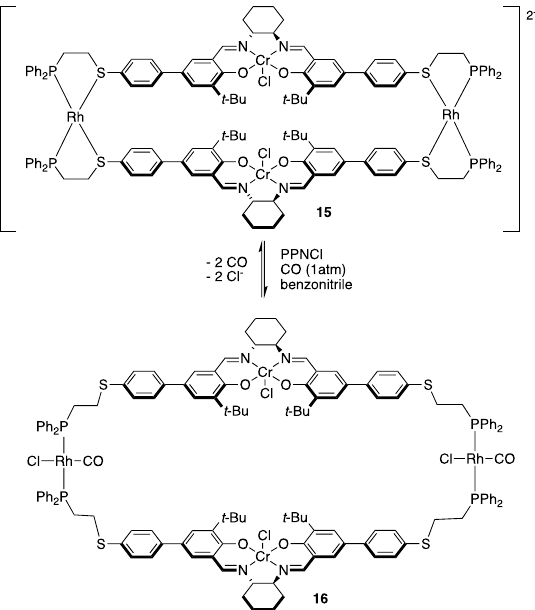
Figure 4. An allosteric supramolecular bissalen catalyst; closed form (top, 15 ) and open form (bottom, 16 ). PPNCl = bis(triphenylphosphoranylidene)ammonium chloride.